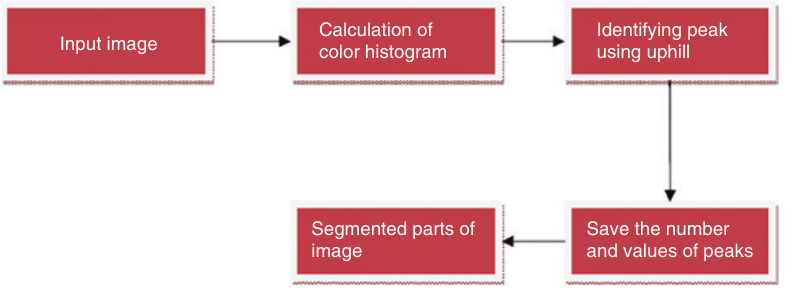
Figure 1: Hill Climbing-Based